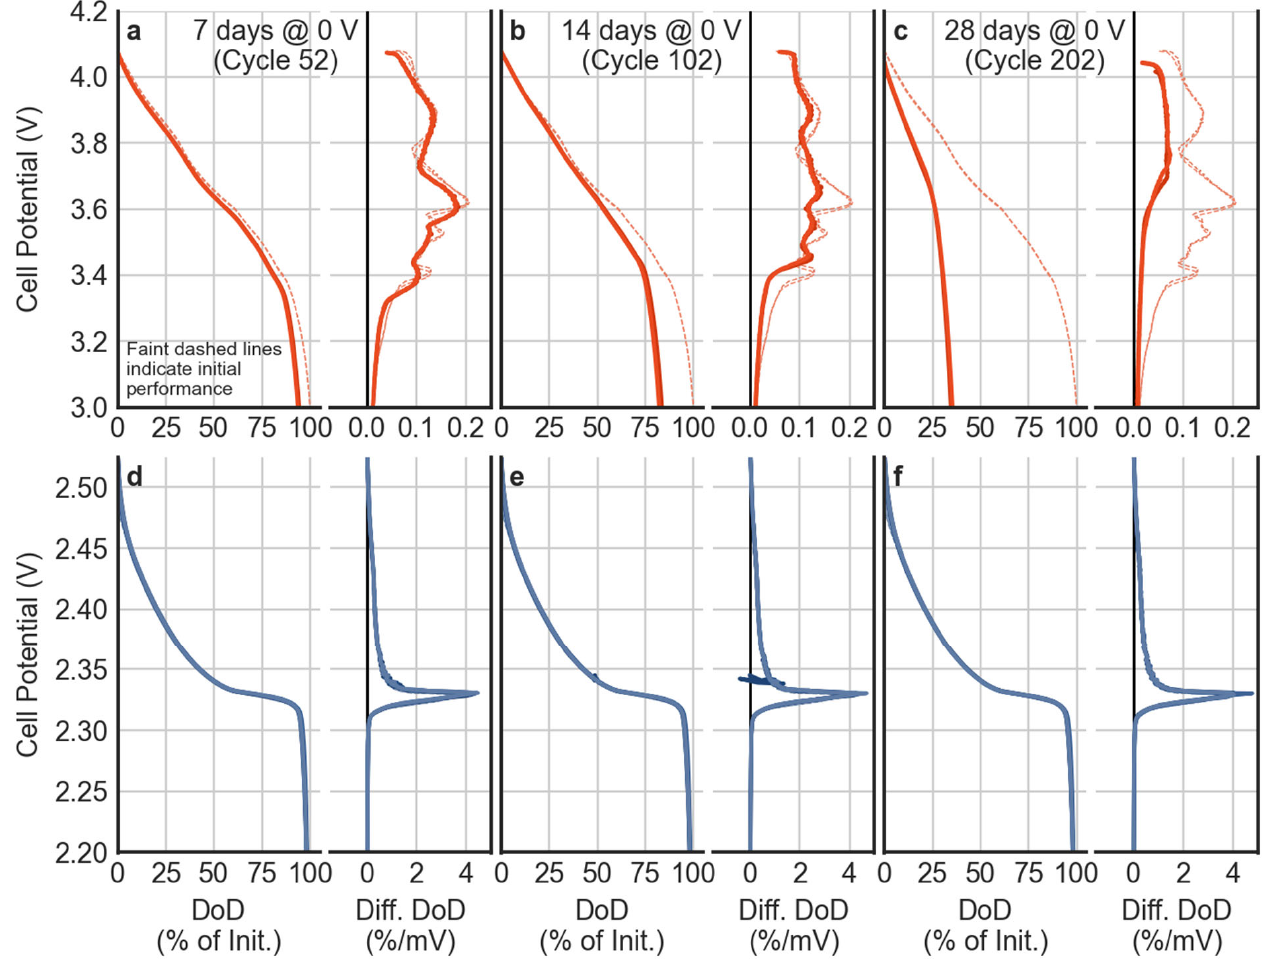
Figure 4. Differential capacity plots for selected C/24 discharge cycles, following different overdischarge regimes. Faint dashed lines represent the initial C/24 discharge performance for each cell. Top row ( a – c ): graphite cells. Bottom row ( d – f ): LTO cells. Left column ( a , d ): performance after 7 days at 0 V. Middle column ( b , e ): performance after 14 days at 0 V. Right column ( c , f ): performance after 28 days at 0 V. Each column shows the cell potential vs. DoD( left ) and differential DoD ( right ). DoDs are normalized to the initial C/24 discharge capacity for each cell. LTO voltage data below 2.2 V is not shown. Plots include faint dashed lines, which show the performance during cycle 2. These are covered by other lines for the LTO cells at all cycle counts.